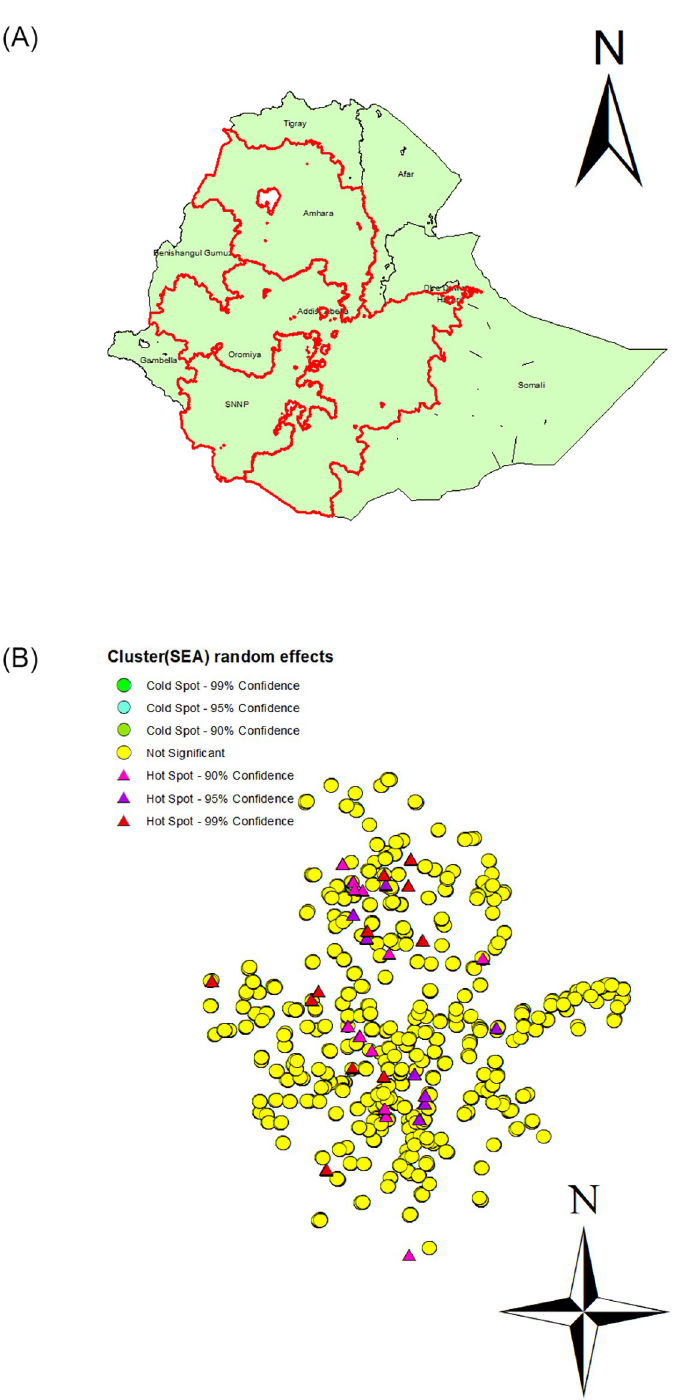
Fig 1. The three regions covering the study area (panel a) and spatial clustering of the BLUP SEAs’ random effects using the Getis-Ord G � statistic. (a) Ethiopia map, (b) Hot-spots. i